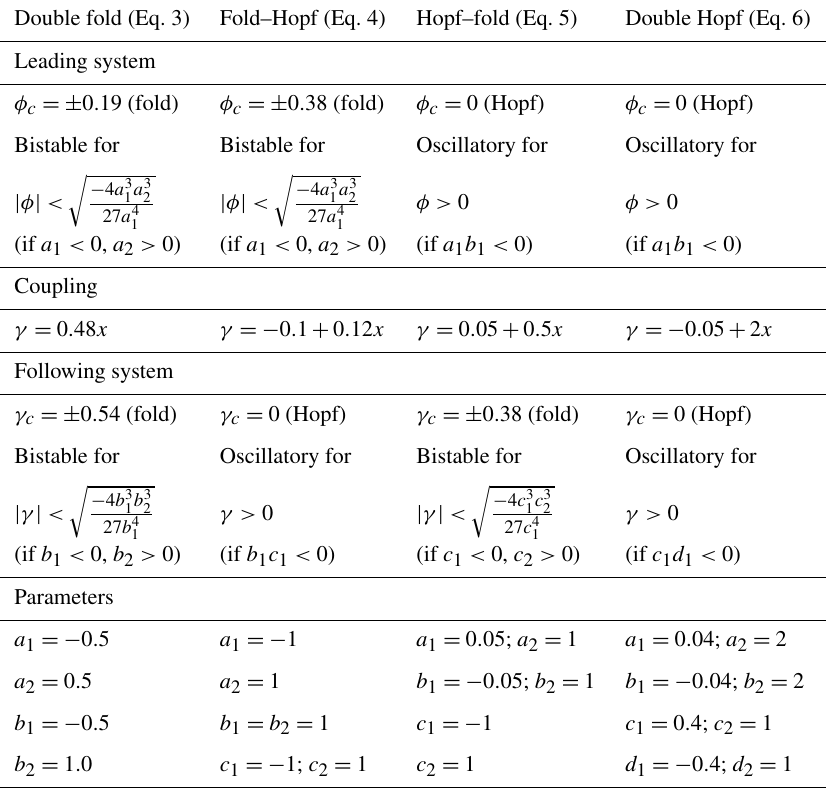
Table 1. Parameter values and coupling for the four types of cascading tipping as shown in Figs. 1 and 2. Double fold (Eq.